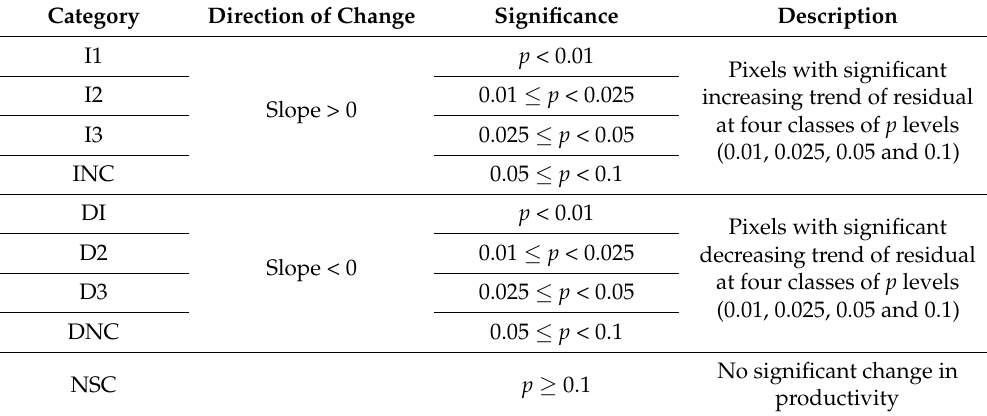
Table 1. Categories of threshold for vegetation